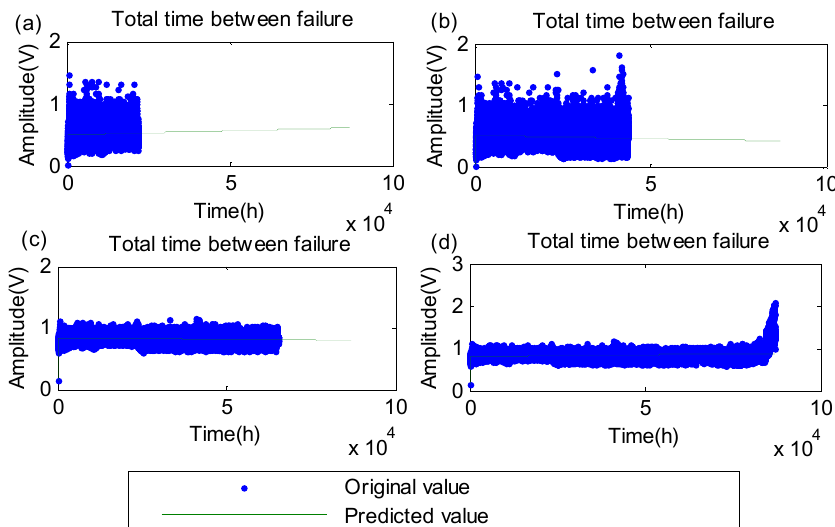
Figure 7. The RUL prognostics results with kurtosis of the original signal utilizing grey theory: ( a ) prognostics result based on 25% of the original data; ( b ) prognostics result based on 50% of the original data; ( c ) prognostics result based on 75% of the original data; ( d ) prognostics result based on 100% of the original data.